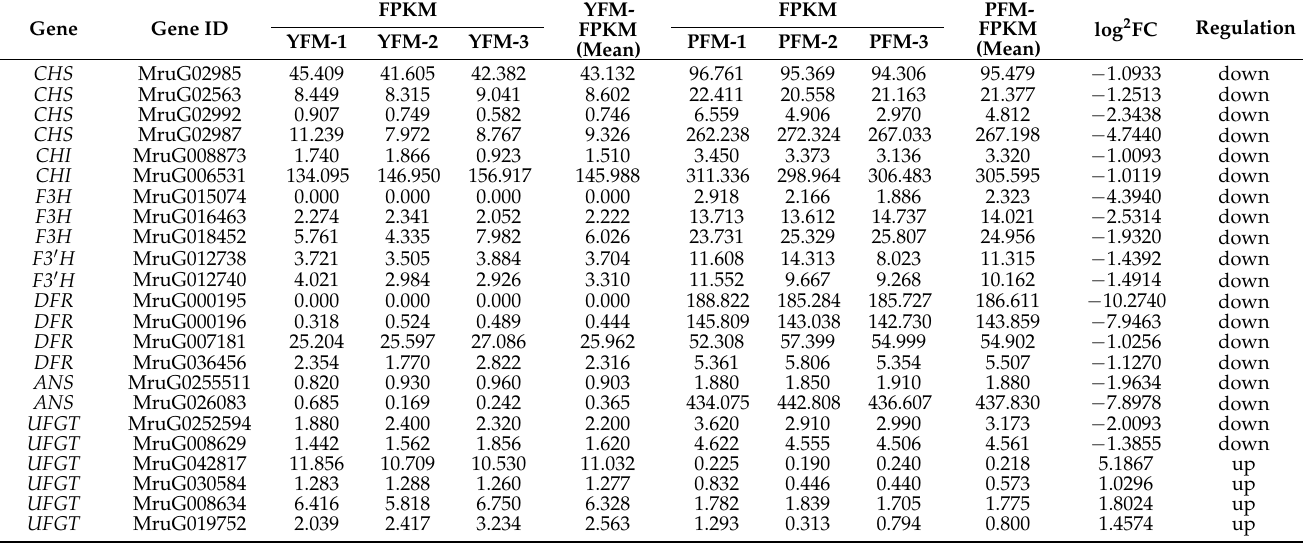
Table 2. Selection of key differentially expressed genes of anthocyanin synthesis pathway in M. ruthenica